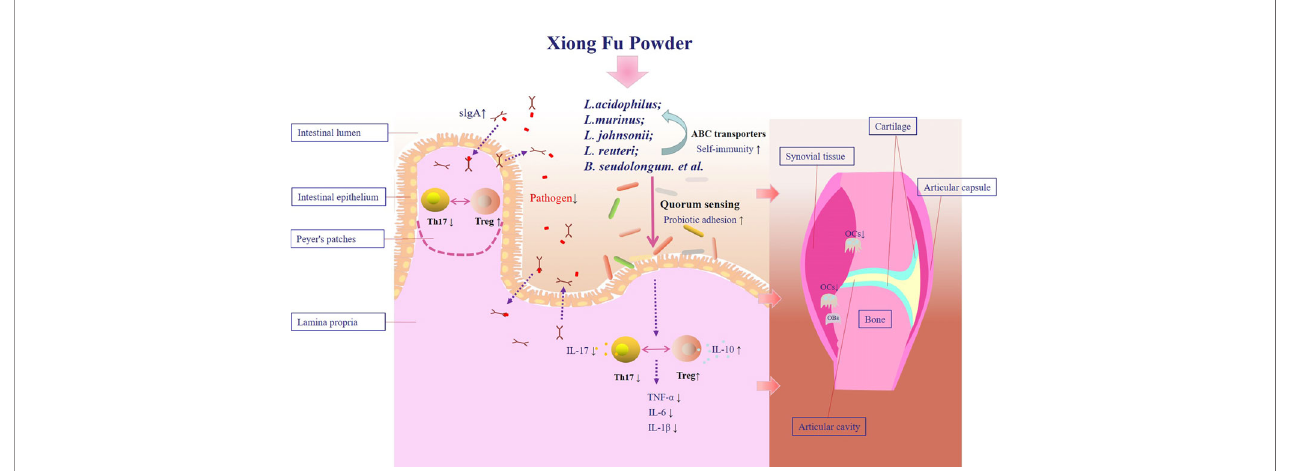
FIGURE 8 | Therapeutic mechanism of XFP in the SD-CIA rat models. XFP, Xiong Fu powder; CIA, collagen-induced arthritis; SD, spleen de fi ciency; SD-CIA, collagen-induced arthritis with spleen de fi